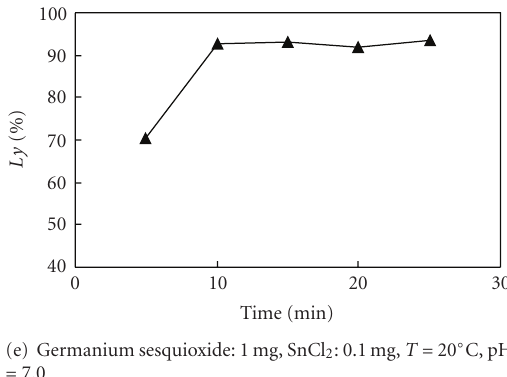
Figure 2: Labeling yields ( Ly s) at di ff erent